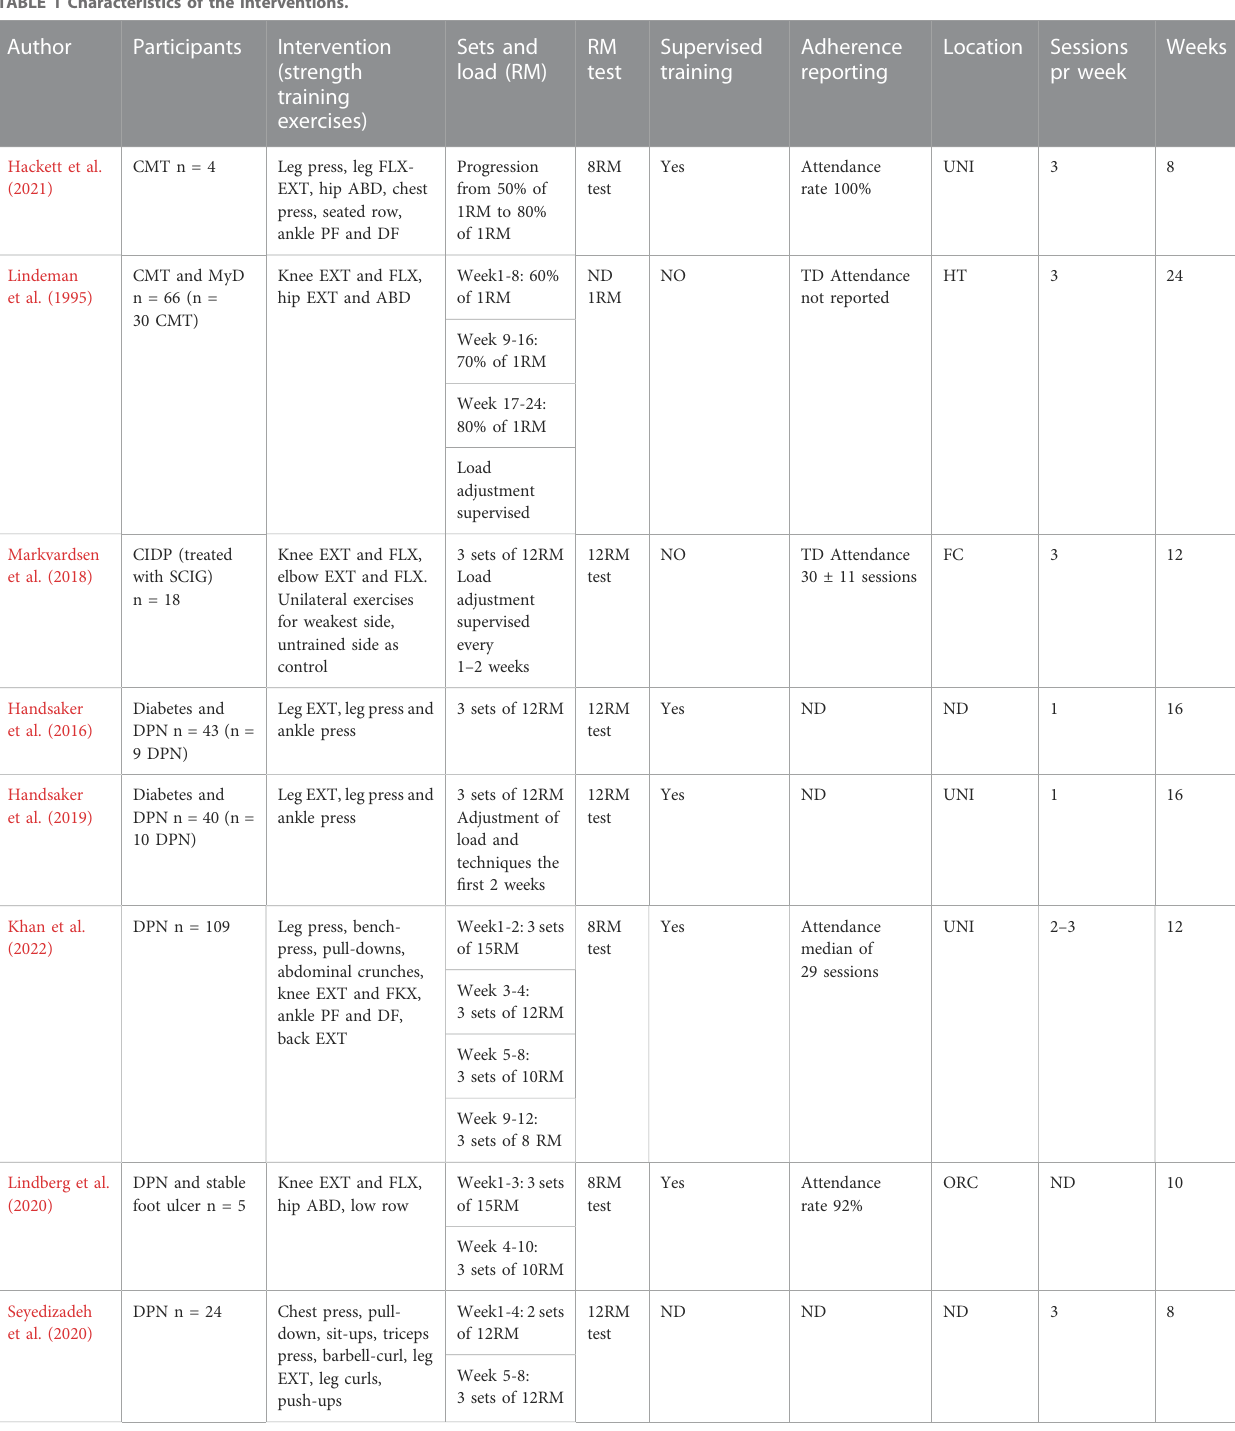
TABLE 1 Characteristics of the